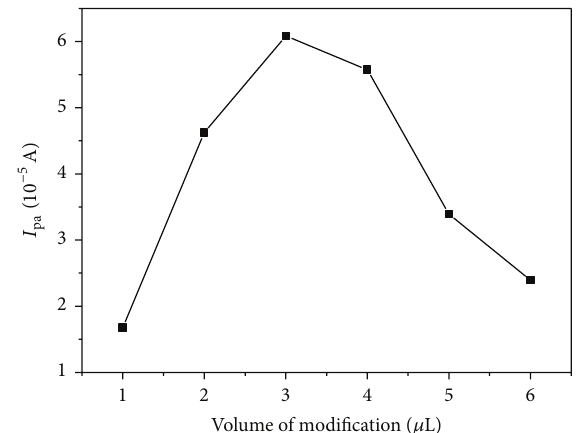
Figure 5: CVs of PDDA-G/GCE in the presence of FA (5.86 × 10 −6 M) with different scan rates (10, 30, 50, 70, 90, 110, 130, 150, 170, 190,210,230,and250 mVs −1 )inpH3.0acetatebuffersolution;inset: the relationship between the logarithm of the peak currents and the logarithm of the scan rates.